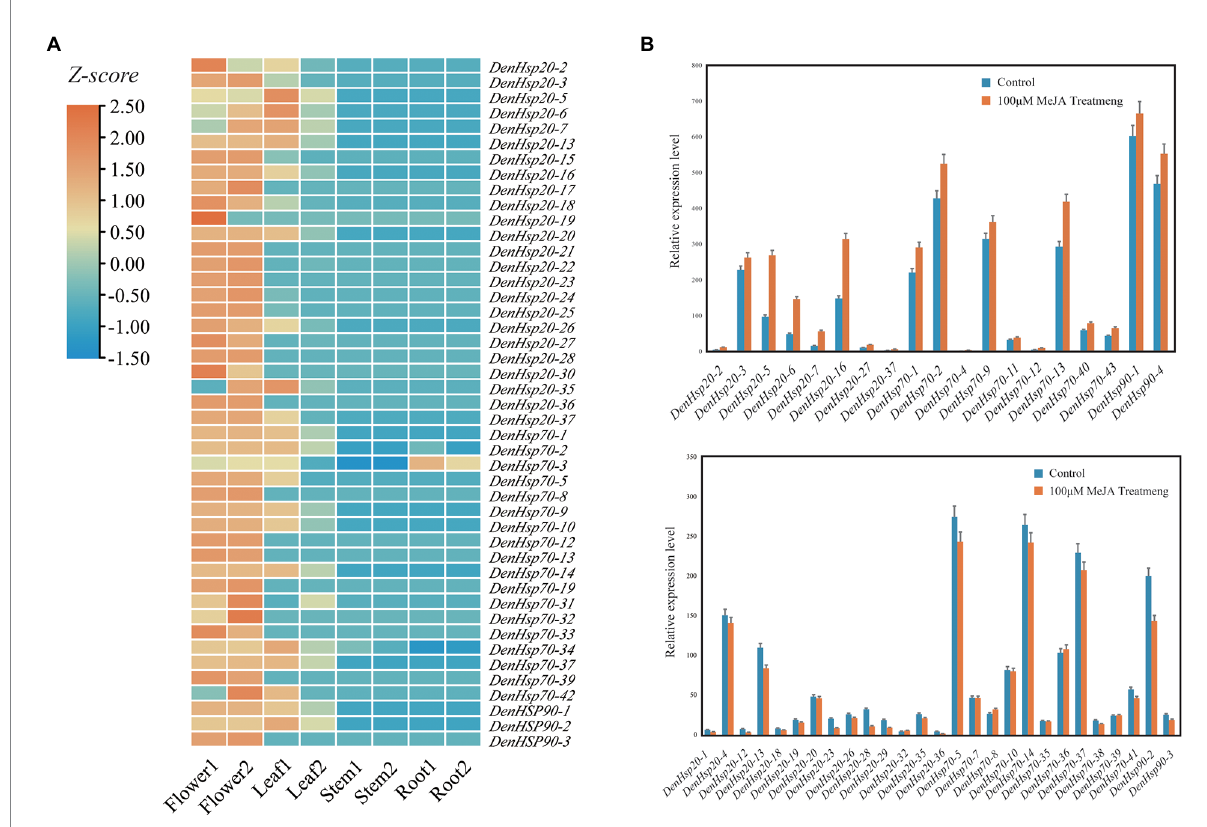
FIGURE 7 Expression analysis of DenHsp20 s, DenHsp70 s and DenHsp90 s in different tissues and MeJA treat. (A) Expression profiles of Hsp20 , Hsp70 and Hsp90 genes of Dendrobium officinale in different tissues including root, stem, leaf and flower. Z-score transformed FPKM values. (B)